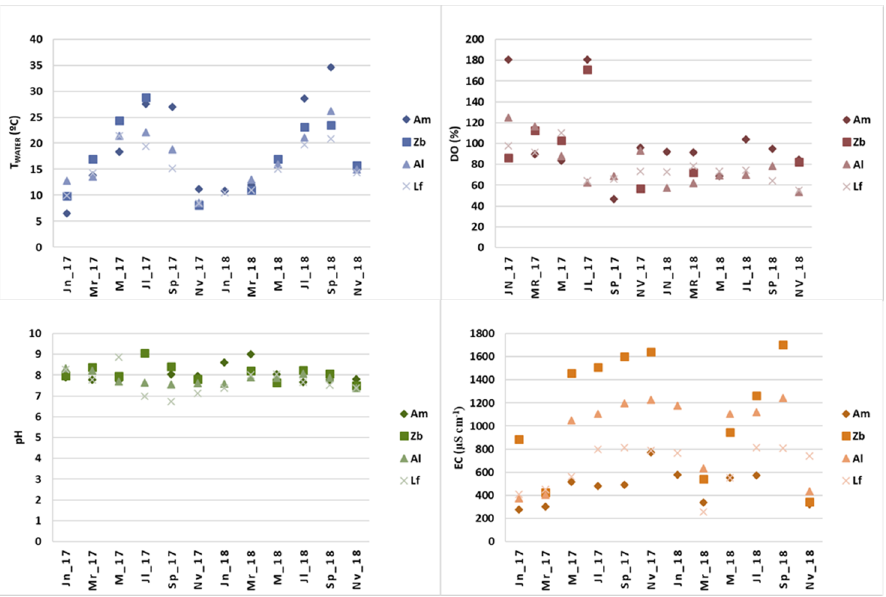
Figure 3. Parameters measured in situ, in each stream (Zb: Zebro; Am: Amieira; Al: Álamos: Lf: Lucef é cit), during the 12 campaigns of the study (Jn_17: January 2017; Mr_2017: March 2017;